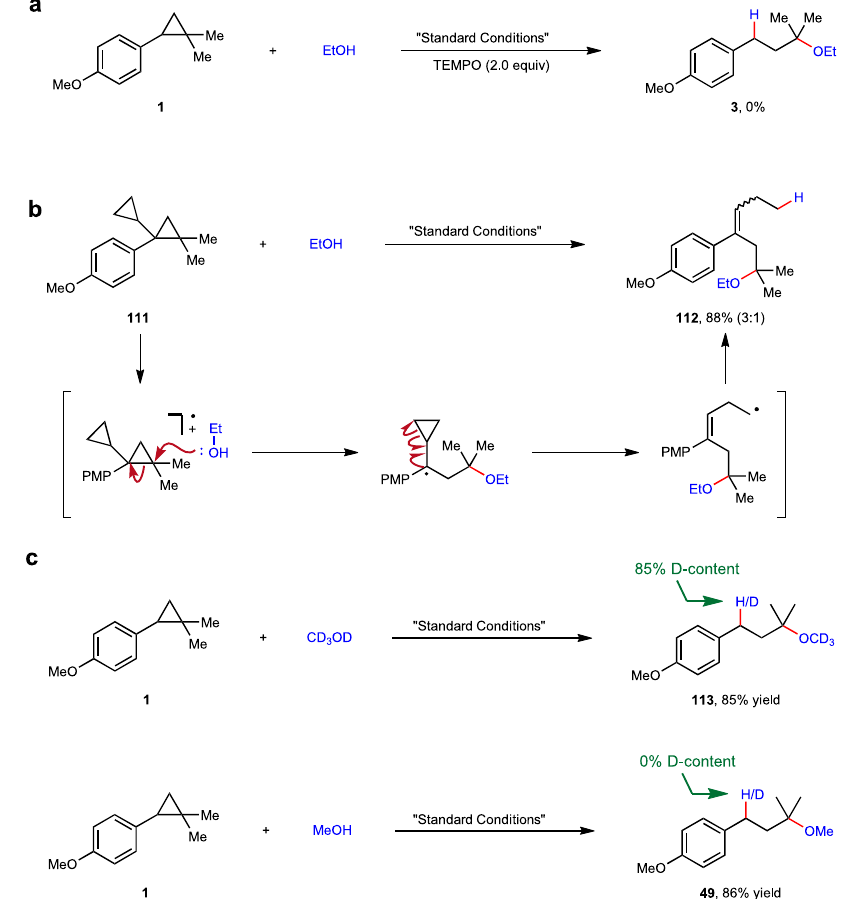
Fig. 6 | Mechanistic Investigations. a Experiment with radical inhibitor. b Radical clock experiment. c Experiments probing the hydrogen source at benzylic site of the product.